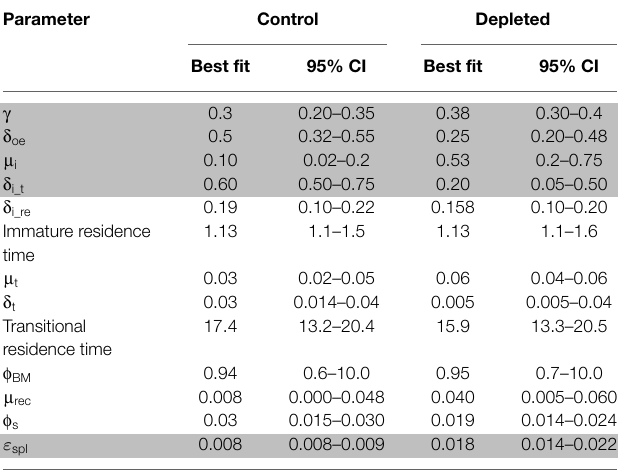
TABLE 1 | The 95% CI for parameter values obtained in simulations of labeling kinetics of control and depleted B cells . Parameter Control Depleted